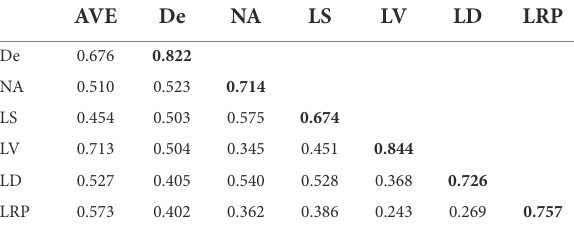
TABLE 8 Discriminate validity test results.